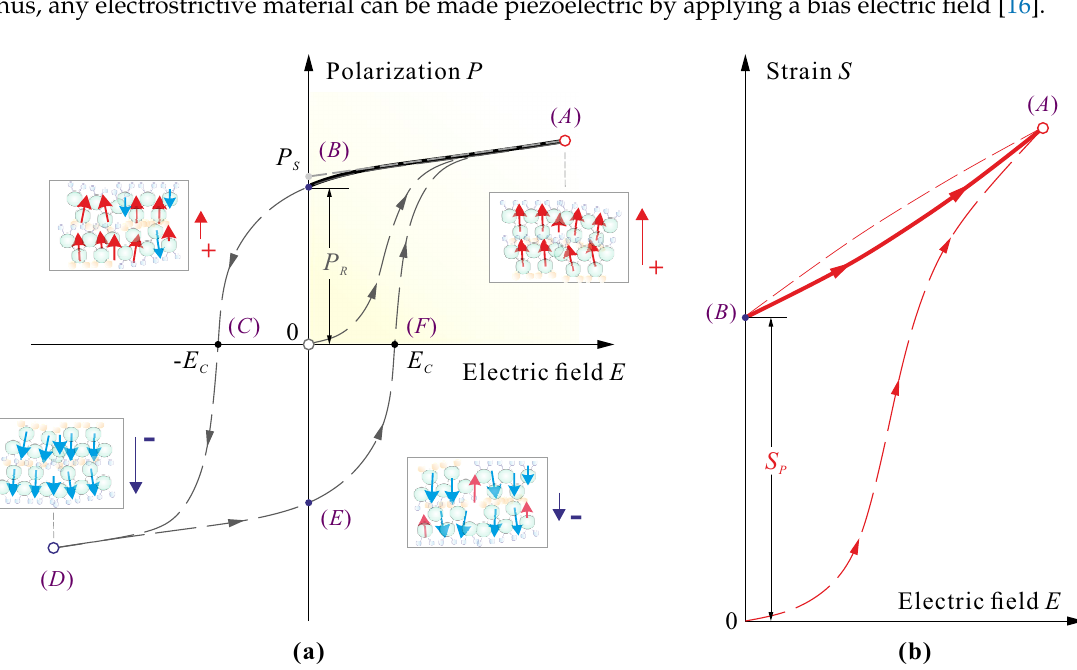
Figure 2. ( a ) Typical polarization diagram of a ferroelectric material and orientation of the domains. P R is the remnant polarization, E C is the coercitive field. ( b ) Typical strain vs. electric field diagram ( S − E ) in the first quadrant. The origin corresponds to virgin material; S P is the poling